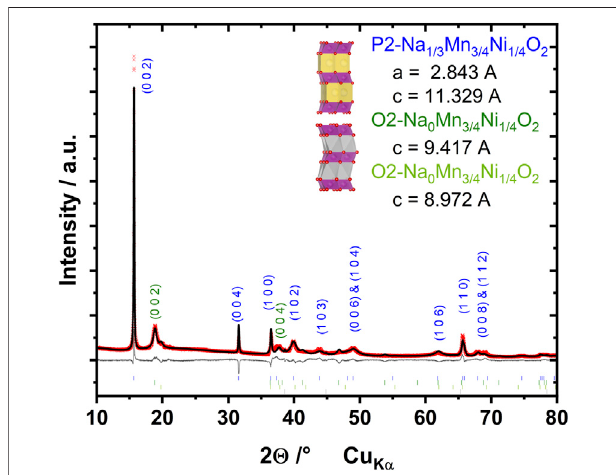
FIGURE10 | Re fi nement of ex-situ XRDpatternofdesodiated electrode at x = 1/6 obtained in capillary transmission. Measured data as red crosses, re fi ned pattern as black line, difference as grey